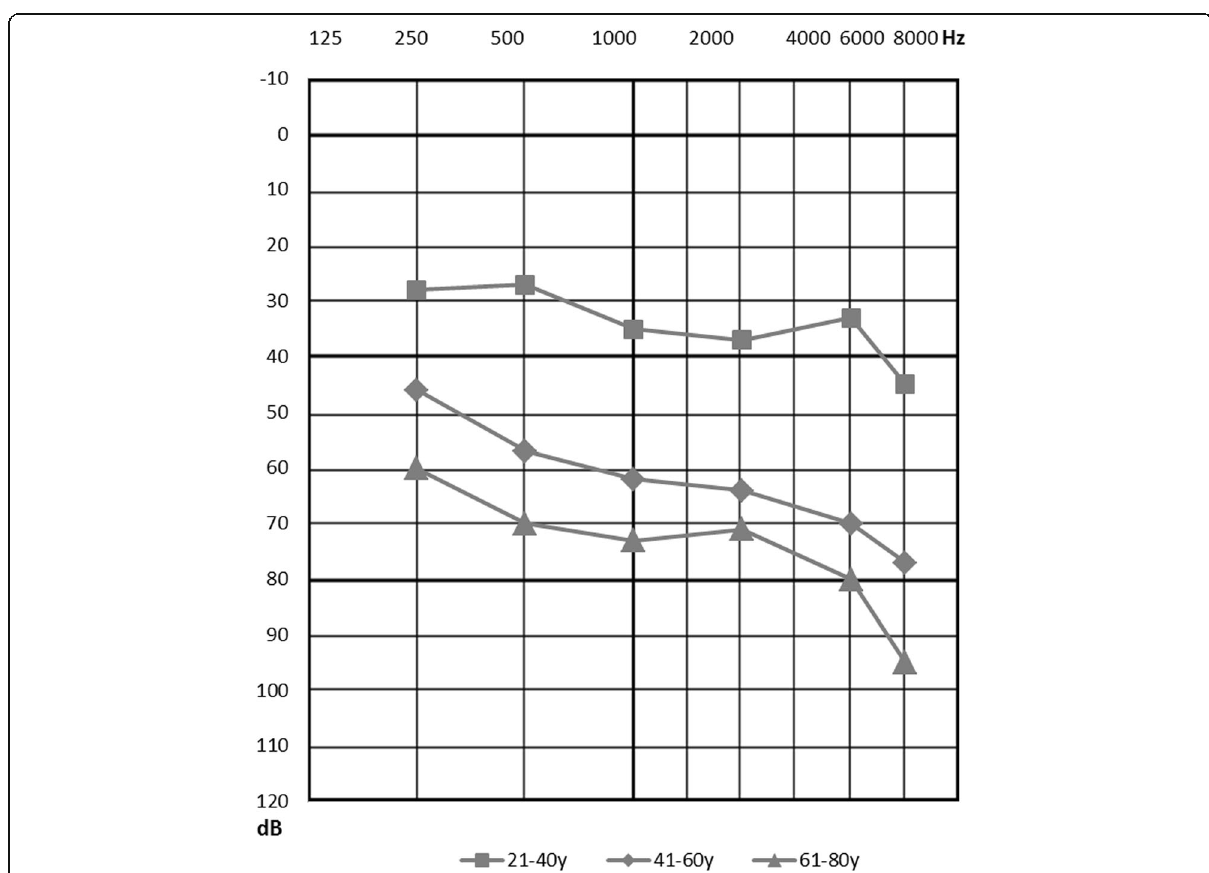
Fig. 3 Age-related typical audiogram demonstrating the progression of hearing loss in different life decades